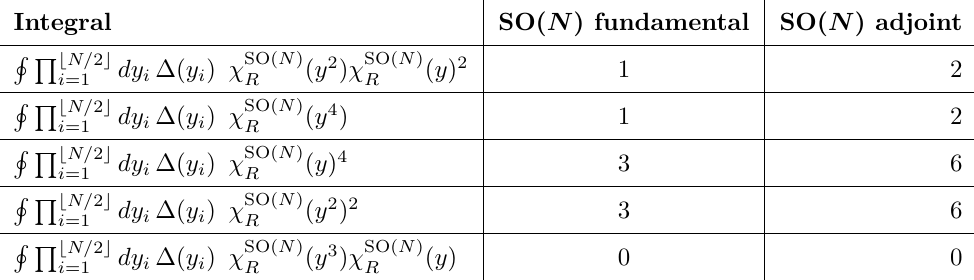
Table 7 . Large N integrals for SO( N ) .